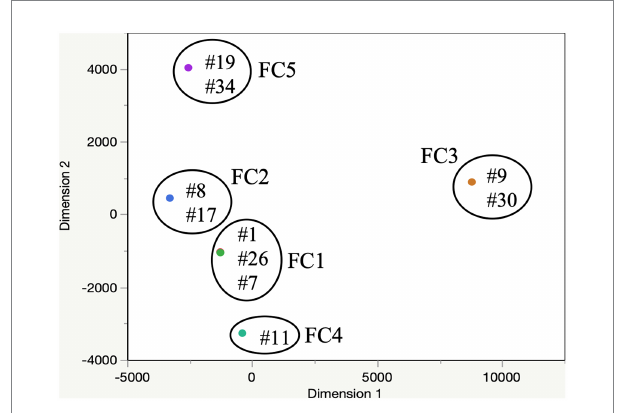
FIGURE 1 Multi-dimensional scaling of 10 SSCF positive for thermophilic Campylobacter. Dimensions 1 and 2 represent distance between farms in meters. Each dot represents a farm selected for the study. #, farm ID; FC, farm